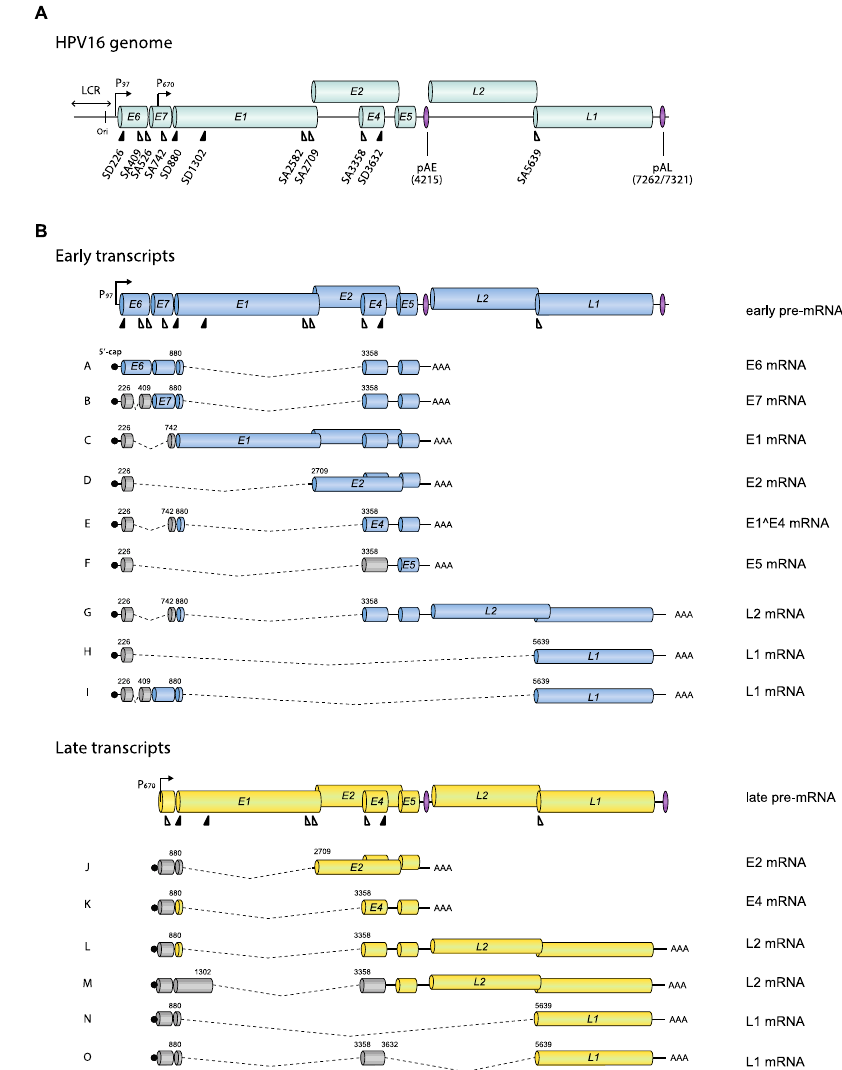
Figure 2. HPV16 genome and transcript map. ( A ) Schematic representation of the HPV16 genome, here depicted as a linearized molecule. Cylinders represent HPV16 early (E1, E2, E4, E5, E6, and E7) and late genes (L1 and L2). HPV16 early and late promoters P97 and P670, respectively, and HPV16 early and late polyadenylation signals pAE and pAL, respectively, are indicated. HPV16 5 (cid:48) -splice sites / splice donors (SD) and 3 (cid:48) -splice sites / splice acceptors (SA) are shown. The long control region situated between the L1 stop codon and the E6 start codon contains the origin of DNA replication and the HPV16 early promoter / enhancer P97. ( B ) A subset of HPV16 mRNAs initiated at the HPV16 early promoter P97 (middle part, blue) or at the HPV16 late promoter P670 (lower part, yellow) are displayed. The transcript map is adapted from the Papillomavirus Episteme website (PaVE) (https: // pave.niaid.nih.gov), except the full E1 mRNA (species C), which has not been identified in HPV16-infected cells. Potential coding capacity is indicated to the right of each